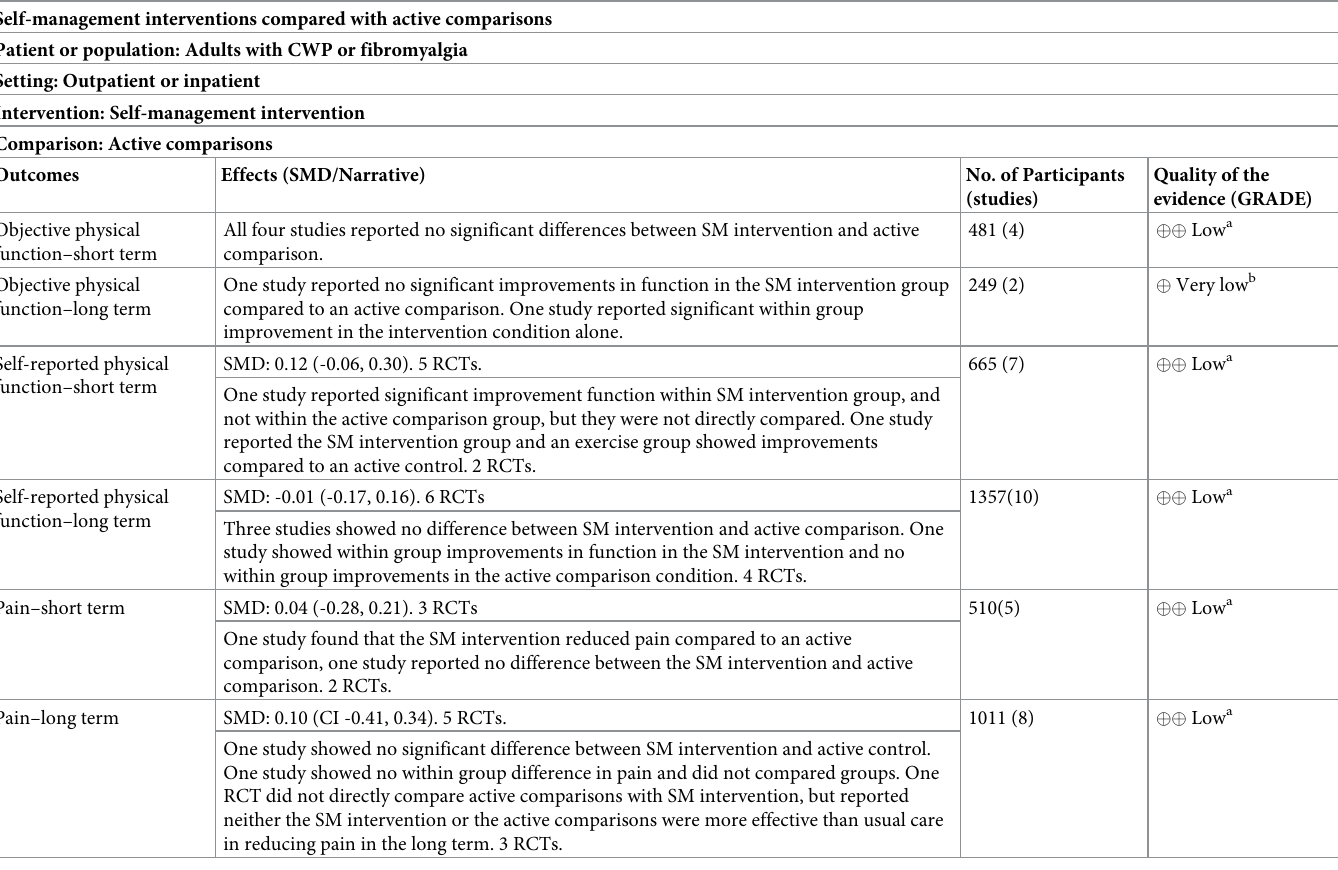
Table 3. Summary of findings: Self-management interventions for chronic widespread pain (CWP) including fibromyalgia. Self-management interventions compared with active